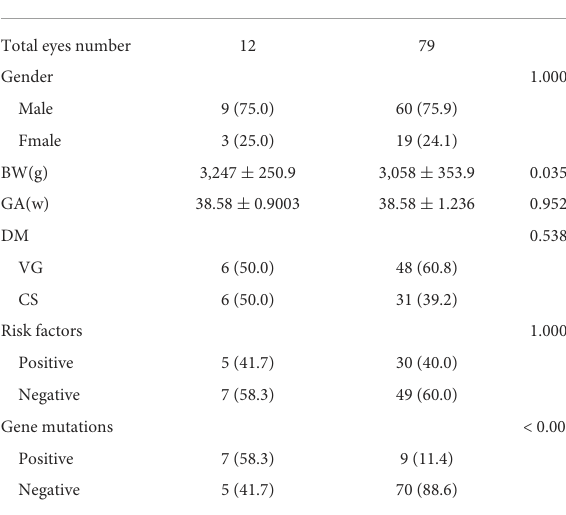
TABLE 2 Multivariate analysis between treatment needed eyes and not requiring treatment eyes. Treatment needed